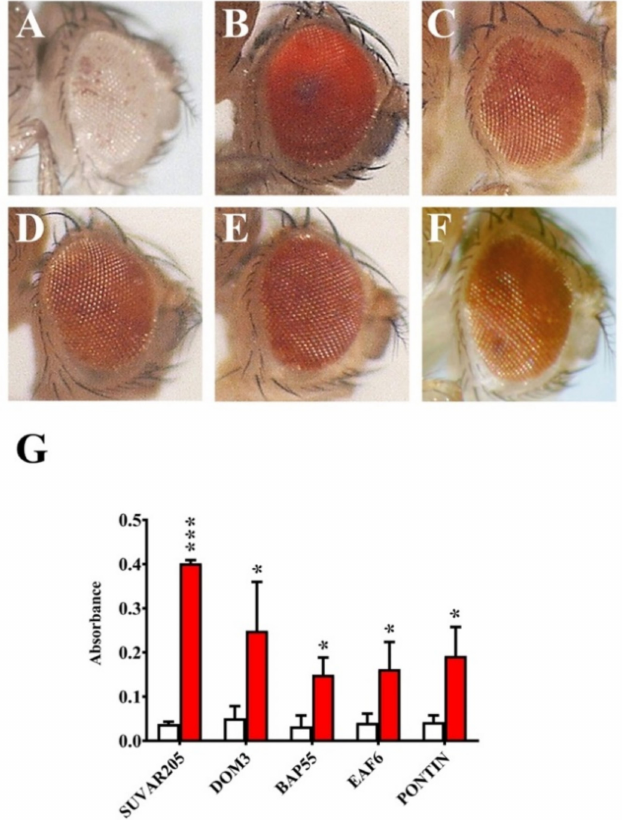
Figure 5 and Table 5. As expected, the In(1)wm4 variegation was suppressed by Su(var)205 and Dom3 mutations. Most importantly, we found that Bap55 EY1596 , Eaf d06605 , and Pontin 5.1 alleles were dominant suppressor of In(1)wm4 variegated phenotype (Figure 5A,B; Table 5). Interestingly, the Dom3 allele failed to suppress the variegated eye phenotype of 7m27 , a variegated Pw+ insertion into the Y chromosome telomeric region [33], which by contrast was efficiently suppressed by Su(var)205) allele (Figure S2).